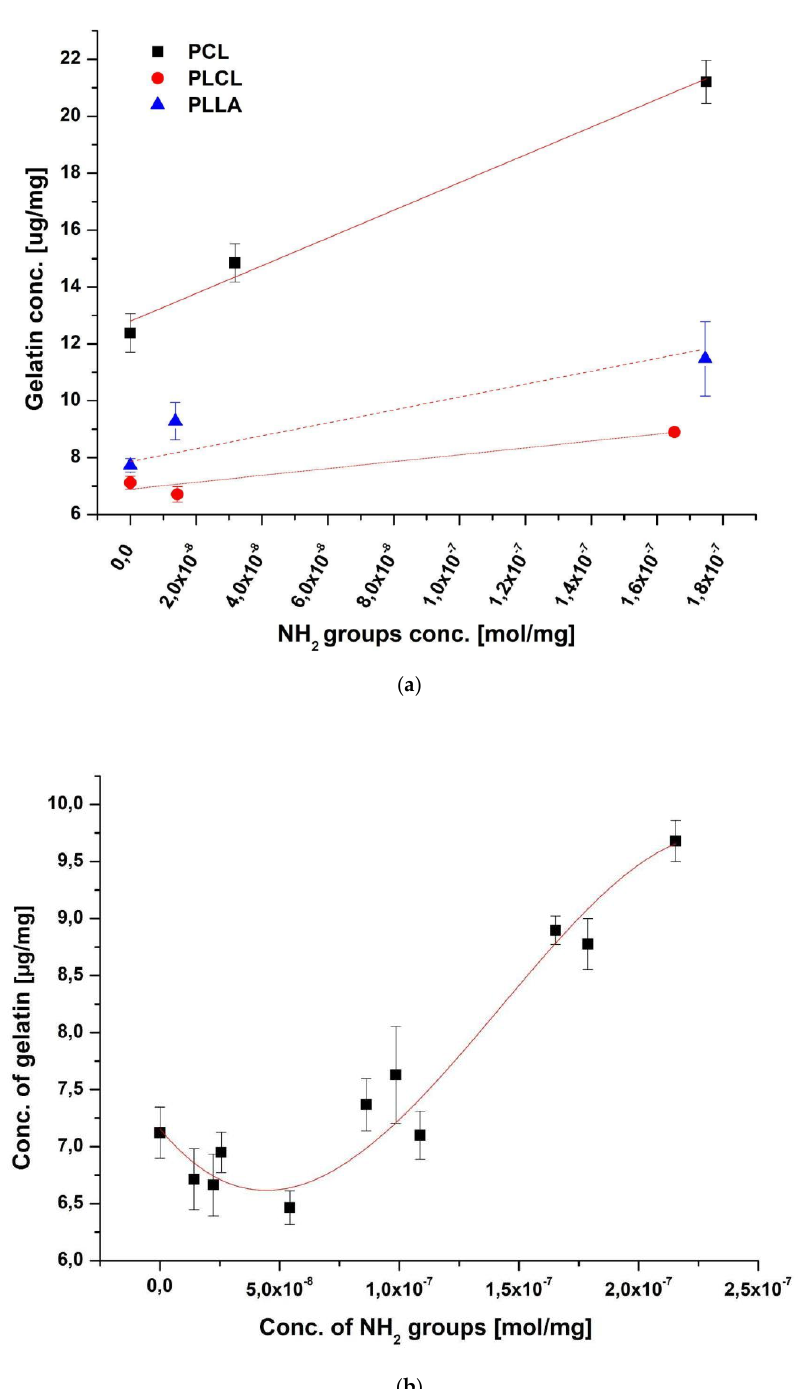
Figure 3. Concentrations of gelatin on the surface of the fibers as a function of free NH 2 groups concentration for ( a ) all investigated polymers (the subsequent amine concentration points on X-axis correspond to physical adsorption, mild chemical and strong chemical immobilization) and ( b ) PLCL